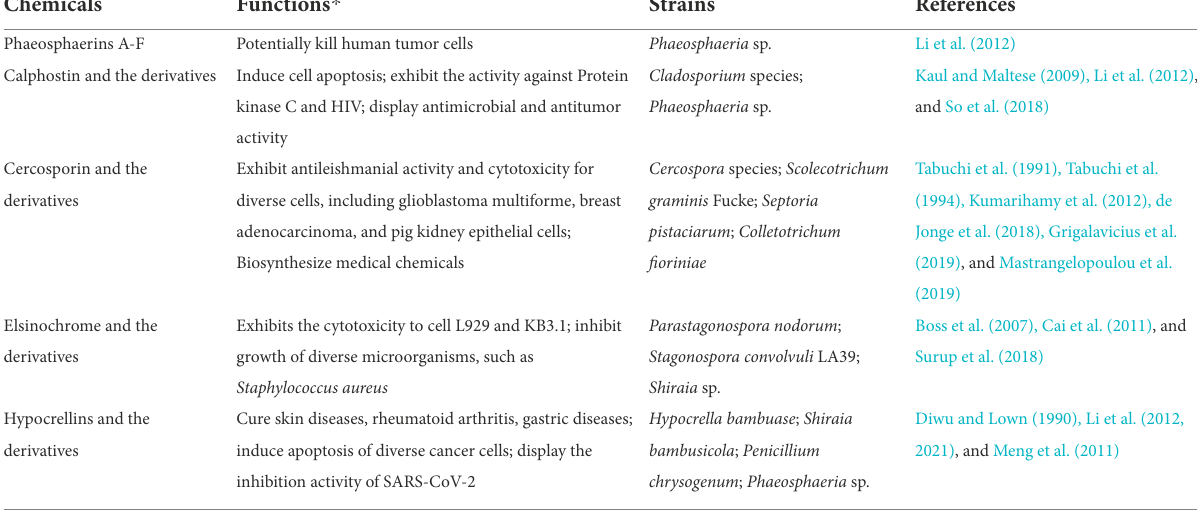
TABLE 1 Functions and original strains of diverse